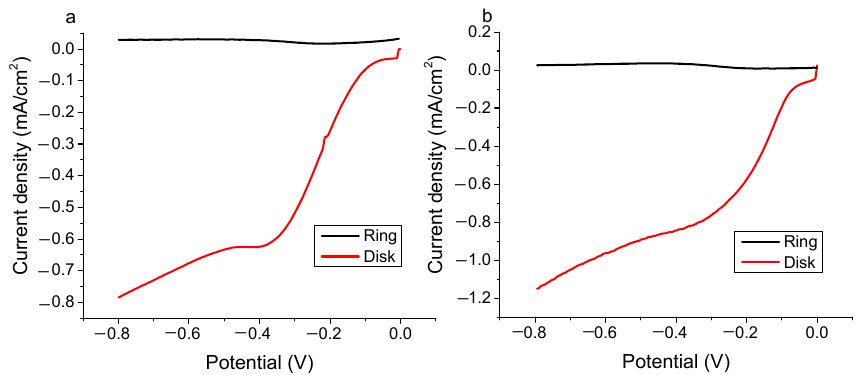
Figure 8. Linear sweep voltammograms of ring vs. disk for ( a ) PNDC and ( b ) SiPNDC at 100 rpm and 50 mV/s sweep rate.